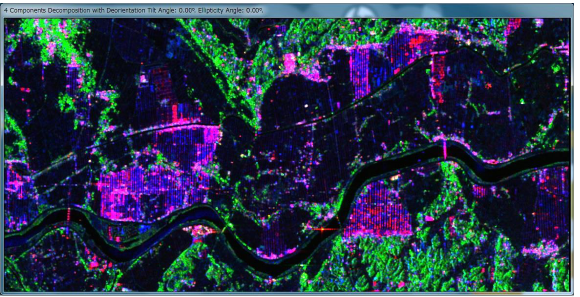
Figure 10. 4-component